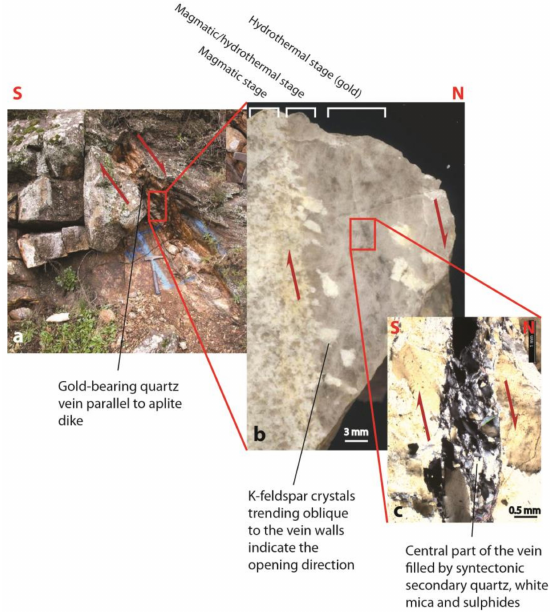
Figure 12. Relationships between gold-bearing quartz vein and granitic dike within the Bru è s granite cupola, Galicia. ( a ) Outcrop view showing the close relationship between quartz vein and granitic dike. ( b ) Sample view showing the transitional contact between granite and quartz hydrothermal vein. ( c ) Thin section of the central part of the hydrothermal vein representative of the mineralised stage. Note the occurrence of dynamic recrystallised quartz and white mica indicating a normal sense of shearing. Red arrows indicate the sense of